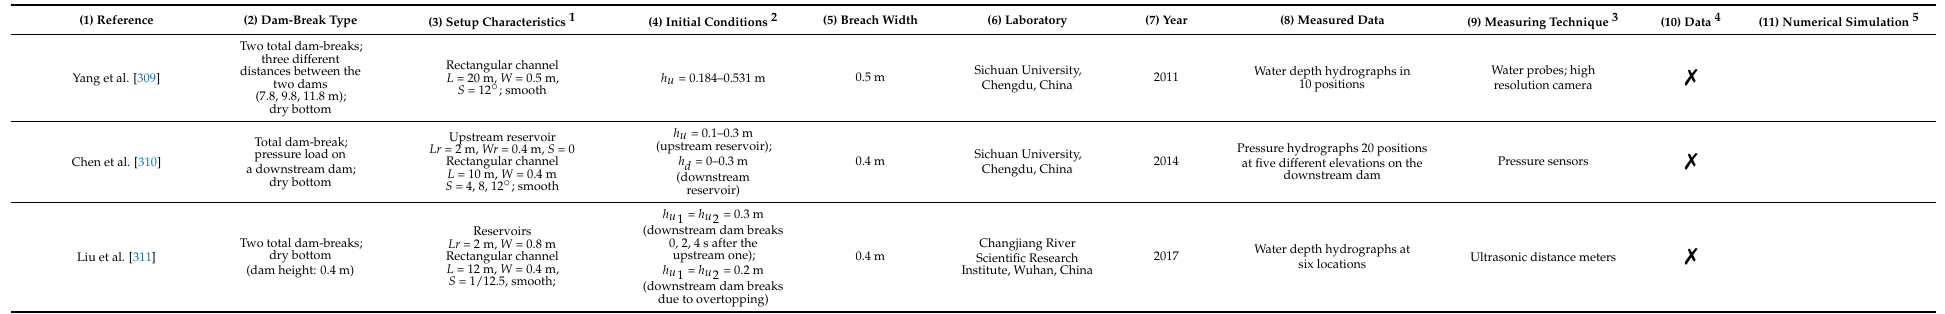
N.A. = not available. Table 8. Experimental investigations of dam-breaks in cascade reservoirs.